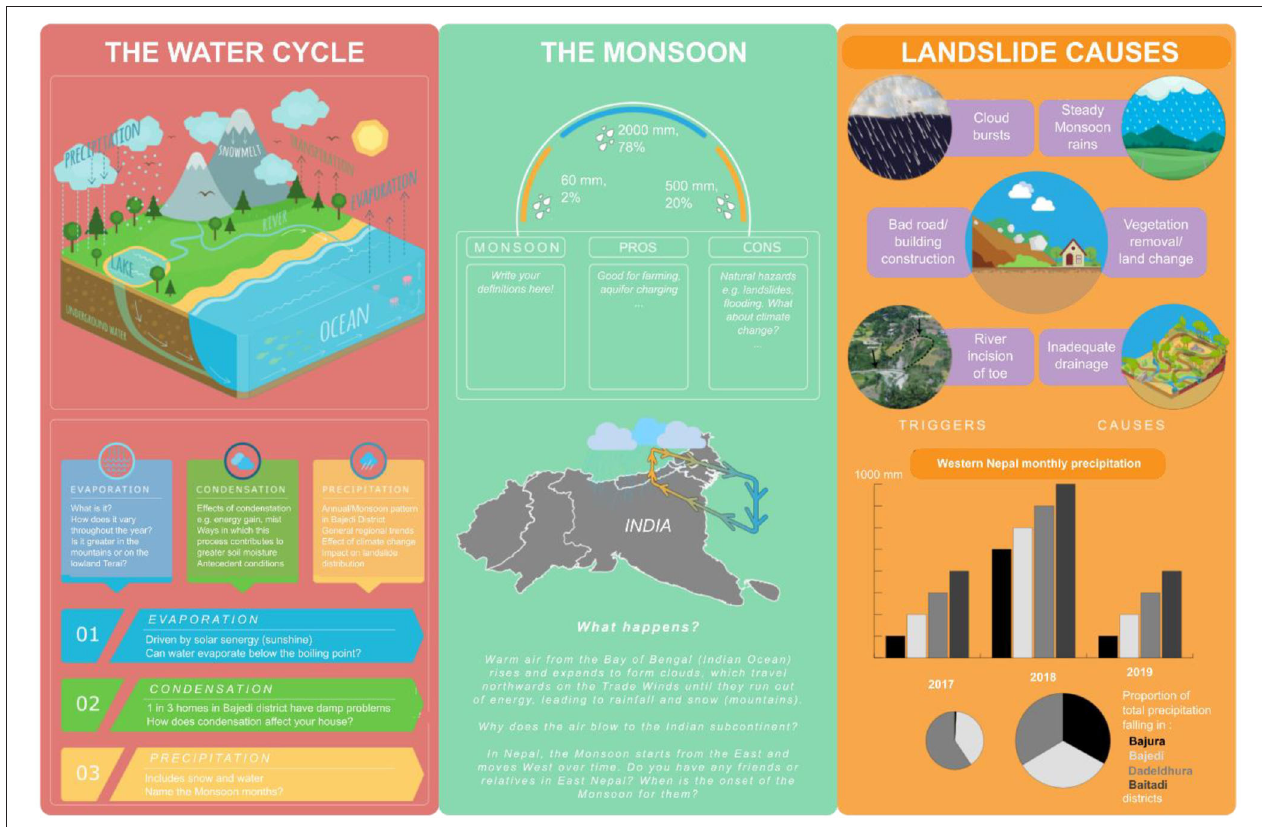
FIGURE 3 | Poster before translation into Nepali, used during the Rainfall session ( Table 2 ) as a primer for discussion between facilitators and students about Monsoon rainfall. In the first instance, students were asked to write on the poster their own suggestions about the causes, challenges, and potential benefits of the Monsoon. One identified “challenge” was landslides, which led onto the next session (Hazards), where facilitators used the right-hand panel of the poster to teach landslide antecedents (e.g., heavily saturated soil or friable bedrock) and triggers (e.g., cloudbursts or